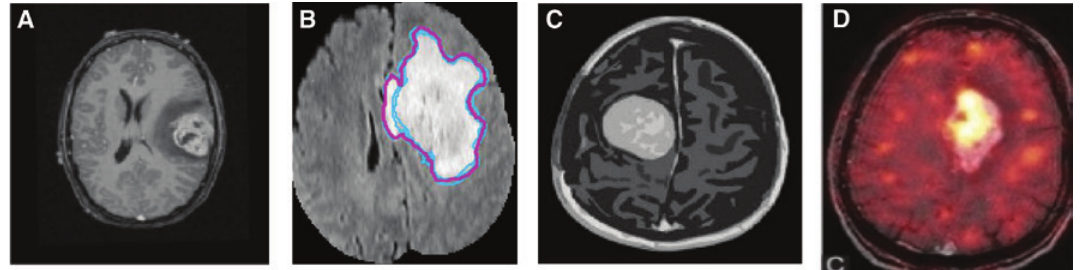
Figure 5: Datasets of Different Modalities.